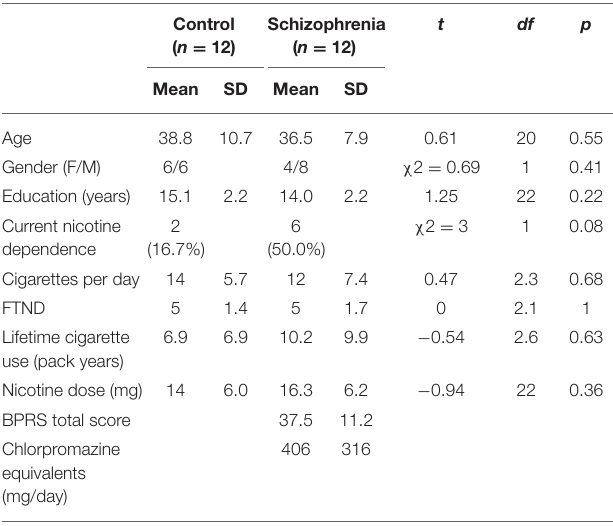
TABLE 2 | Cohort 2: Demographics and clinical